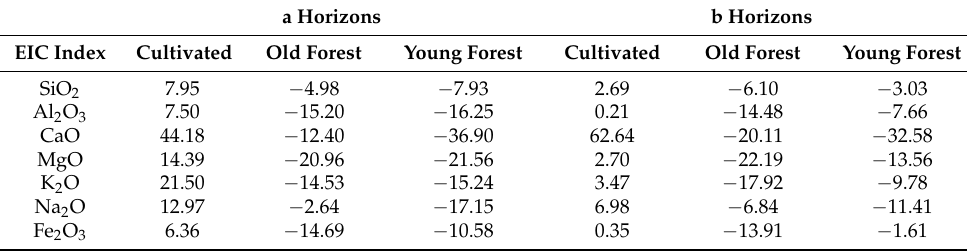
Table 5. Differences in weathering indices in cultivated areas and forested areas. a Horizons b